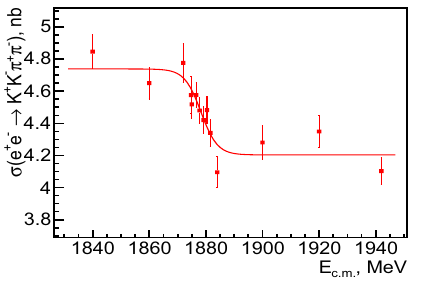
Figure 5. Preliminary result for the cross section of the e + e − → K + K − π + π − process near the N ¯ N thresh- old.